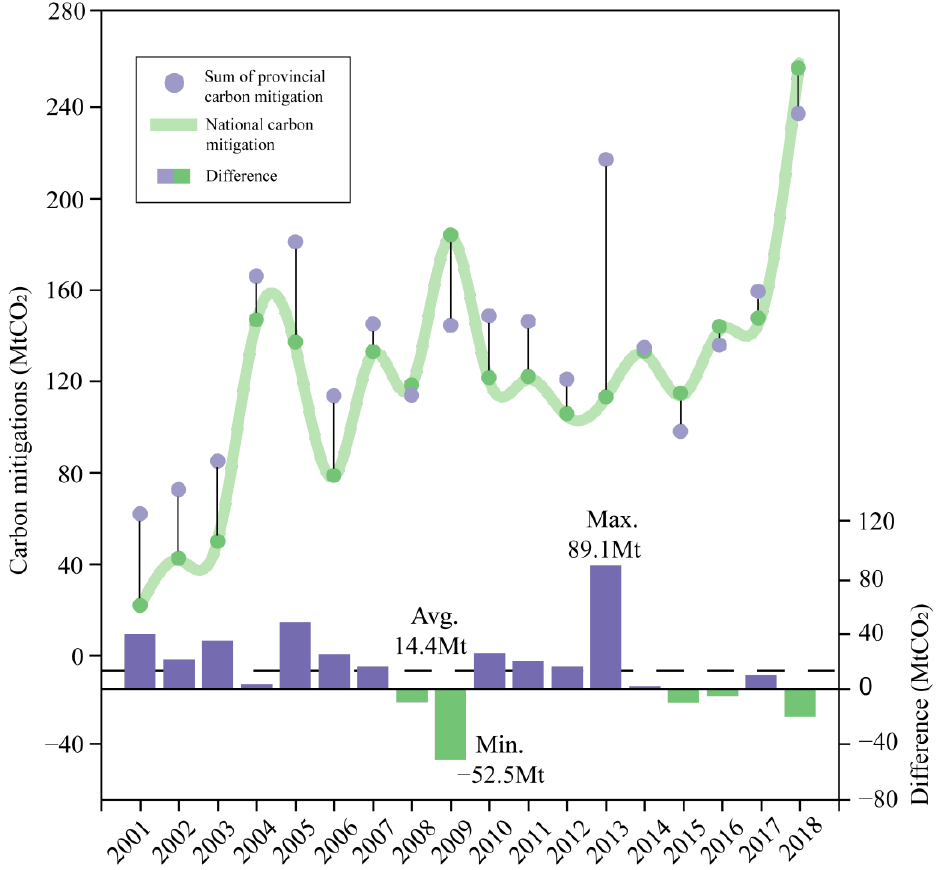
Figure 6. Differences of carbon mitigations at national and provincial scales (2001 – 2018). Additionally, there was a significant difference in carbon mitigations at the two scales in 2013, with 201.0 MtCO 2 at the provincial scale and 111.9 MtCO 2 at the national scale, a